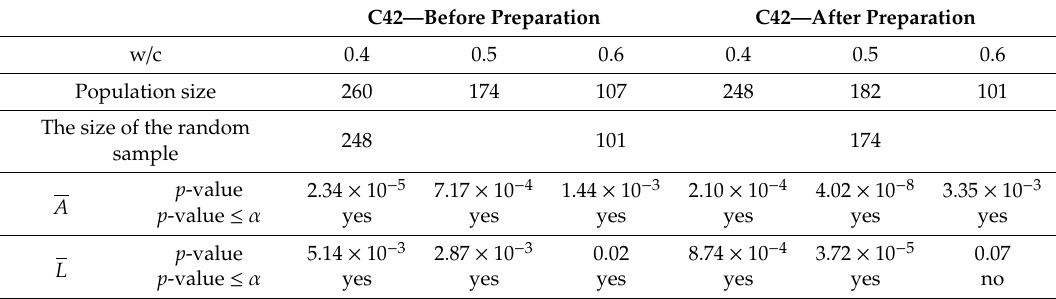
Table 2. The Shapiro-Wilk test